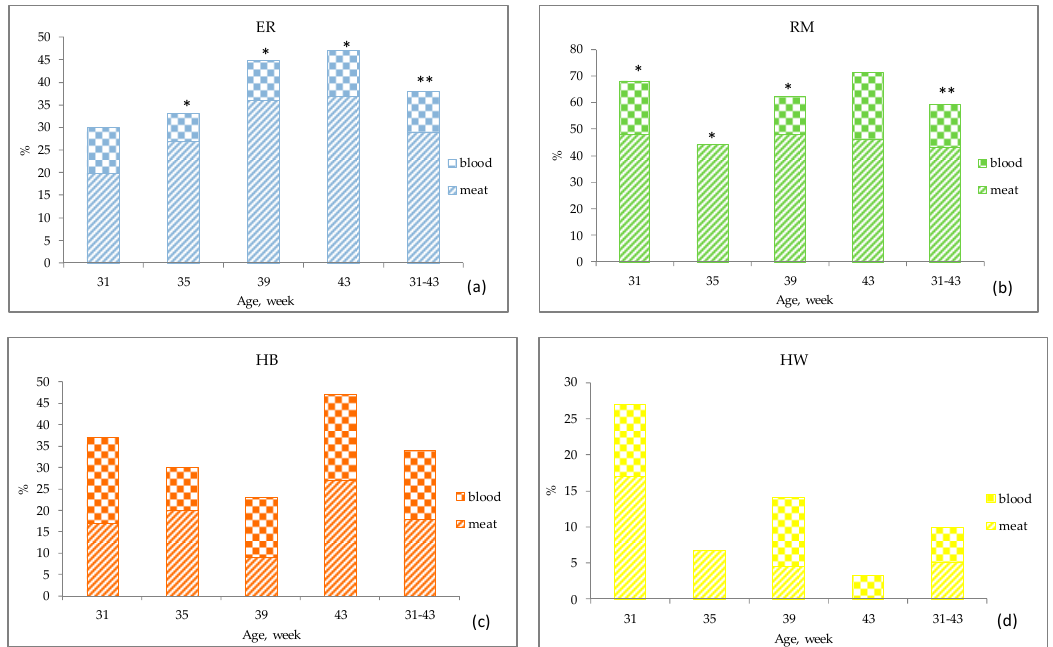
Figure 6. Yolk (blood spots) and albumen (meat spots) quality of each genotype 1 according to the age of the hens. Di ff erent symbols on the columns at each age indicate di ff erent values. *: p < 0.05; **: p < 0.01. 1 Genotype: ER—Ermellinata di Rovigo; RM—Robusta maculata; HB—Hy Line Brown; HW—Hy Line White 36. Observations ( n ) per age (at 31, 35, 39, 43 weeks): ER (30, 30, 22, 30); RM (25, 16, 21, 24); HB (30, 30, 22, 30); HW (30, 30, 22, 30). χ 2 p -value per age (at 31, 35, 39, 43 weeks): ER (0.28, 0.04, 0.03, 0.01, total period 0.002); RM (0.03, 0.03, 0.02, 0.13, total period 0.004); HB (0.74, 0.45, 0.64, 0.54, total period 0.99); HW (0.45, not determined, 0.55, 0.32, total period 0.99).